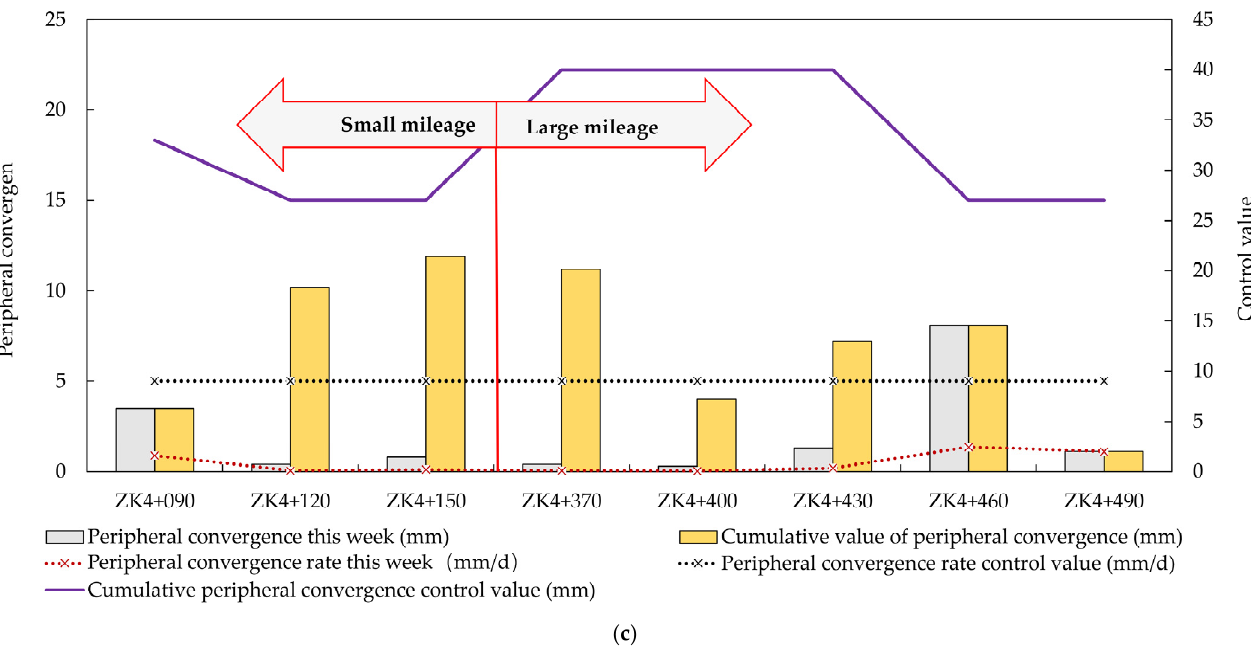
Figure 6. Peripheral convergence of the three measurement lines: ( a ) measurement line H 1 ; ( b ) measurement line H 2 ; and ( c ) measurement line H 3 .